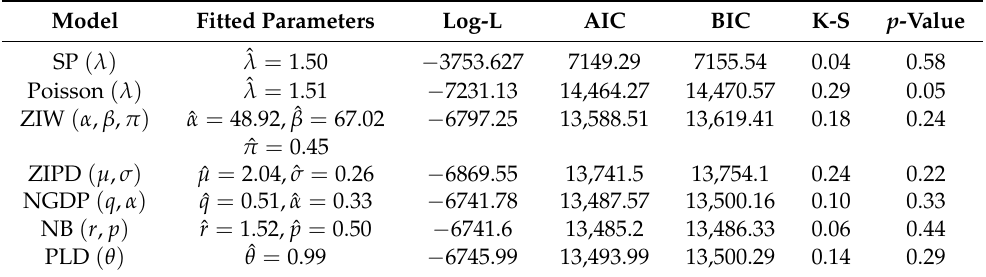
Table 4. Comparing model fits for the insurance claims data.